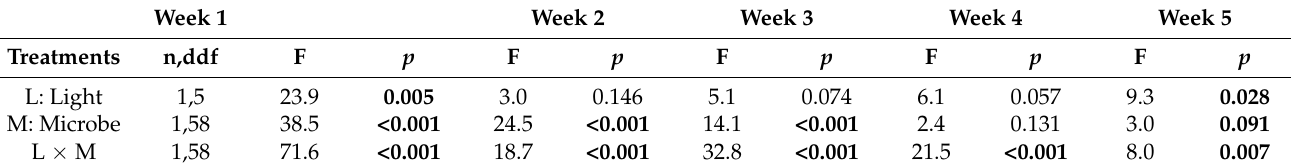
Table 1. General linear mixed models of the effects of light and microbial inoculation on no-herbivore plant height during early growth.